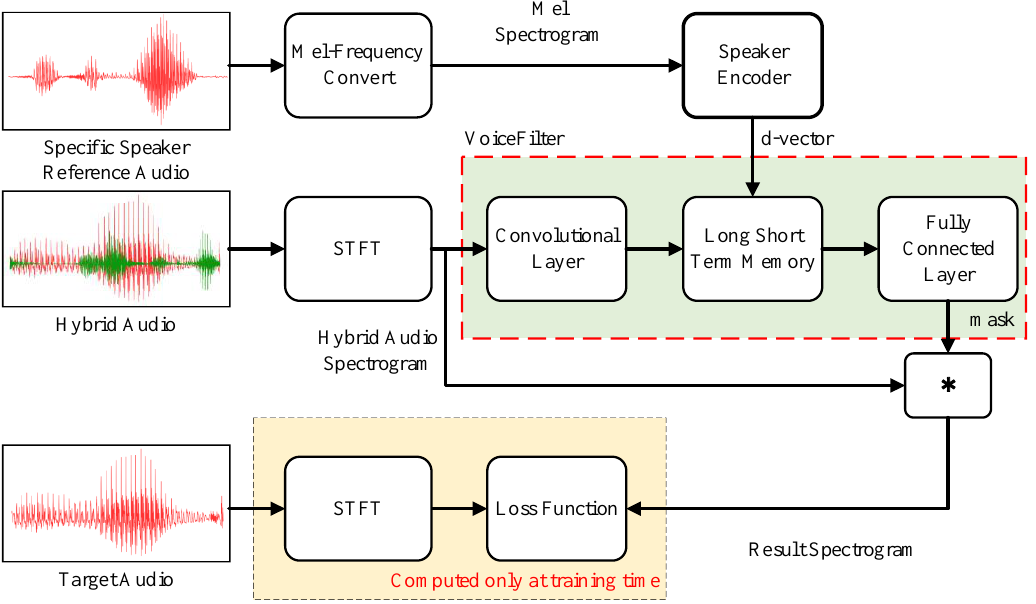
Figure 3. Voice filter architecture diagram.